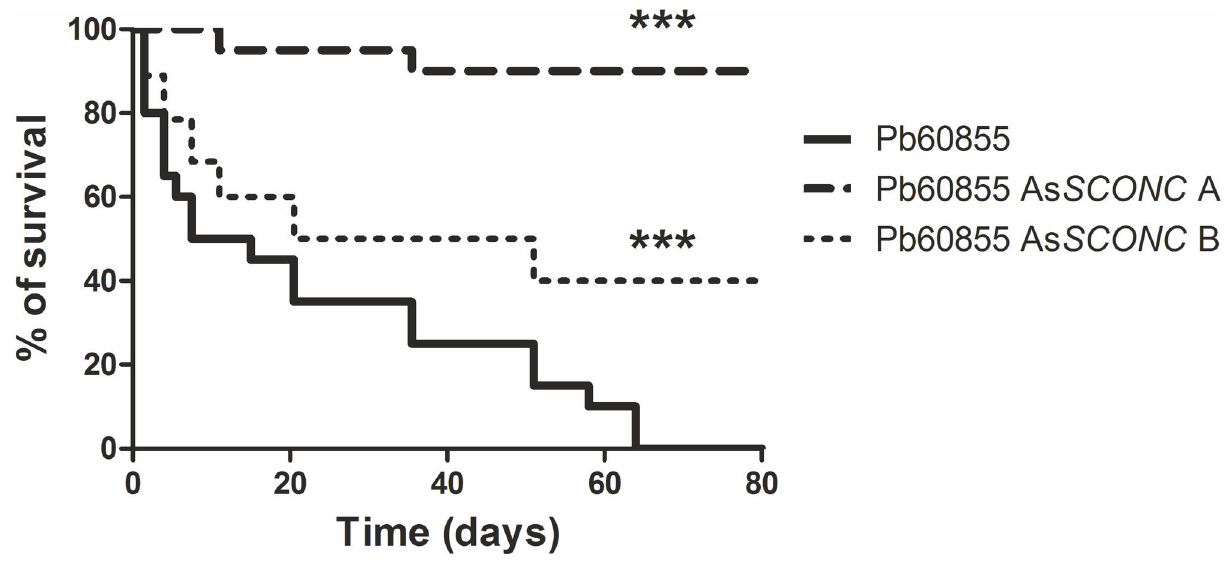
Figure 7. Silencing of SCONC decreases virulence of P. brasiliensis yeast cells. Representative survival curves of an experimental i.v. infection carried out in C57BL/6 mice (n=20) with 1x10 6 wild-type Pb60855, Pb60855 As SCONC A and Pb60855 As SCONC B yeast cells grown to the exponential phase in BHI. Asterisks represent significant differences between mice infected with Pb60855 and mice infected with either Pb60855 As SCONC A or Pb60855 As SCONC